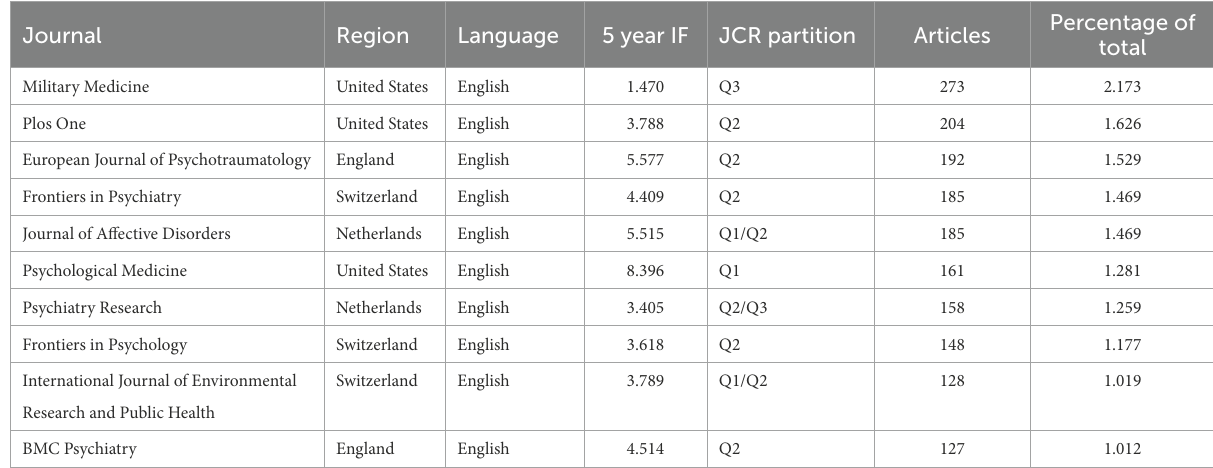
TABLE 1 Top 10 journals contributed to scientific research on